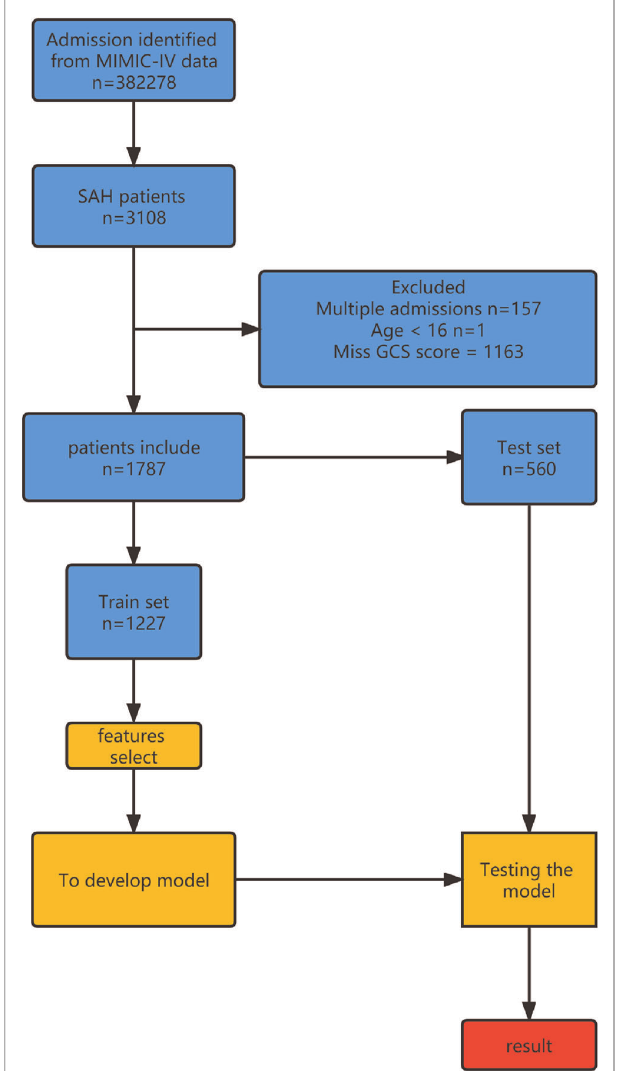
FIGURE 1 | Overview of the methods used for data extraction, training, and testing. MIMIC-IV, Medical Information Mart for Intensive Care-IV; SAH, subarachnoid